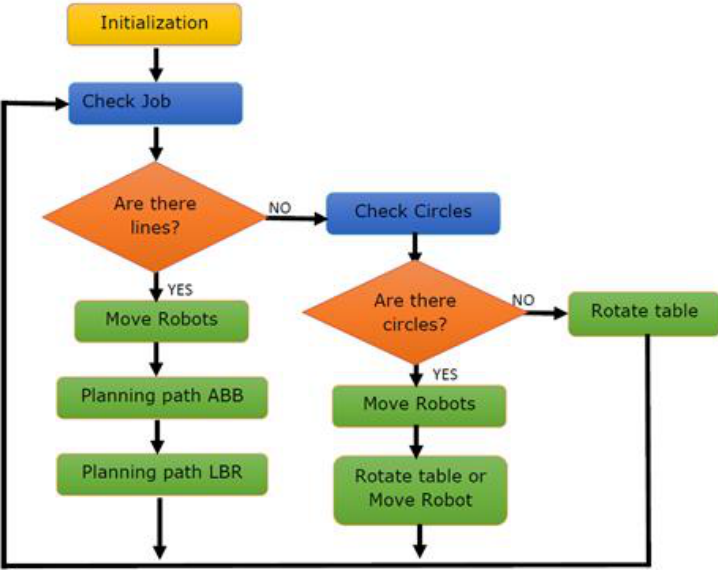
Figure 4. Self-organization algorithm implemented for collaborative robot welding with external axes of a turn and tilt table.